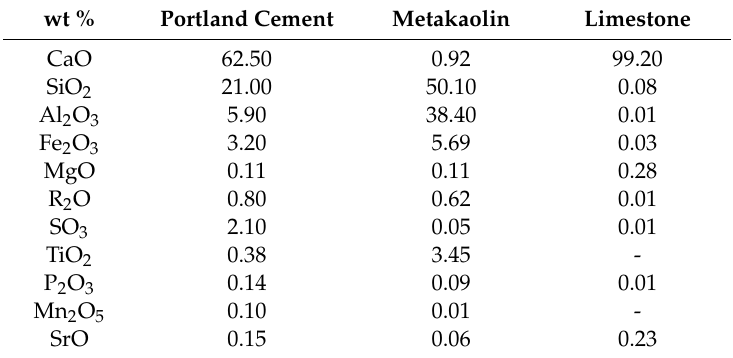
Table 1. Chemical composition of the raw materials used in this study.